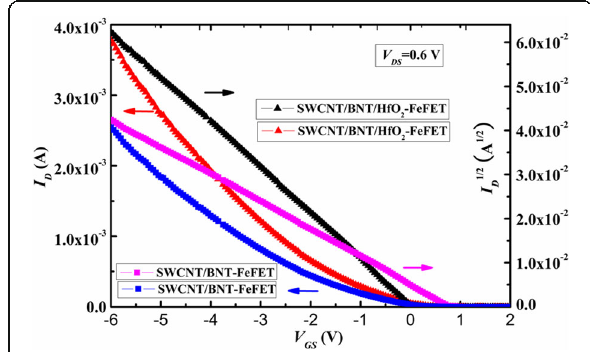
Fig. 4 The linear transfer characteristics curve and fitted I DS1/2 - V G curve at V DS = 0.6 V for the stripe patterned of SWCNT/BNT/HfO 2 - FeFET and